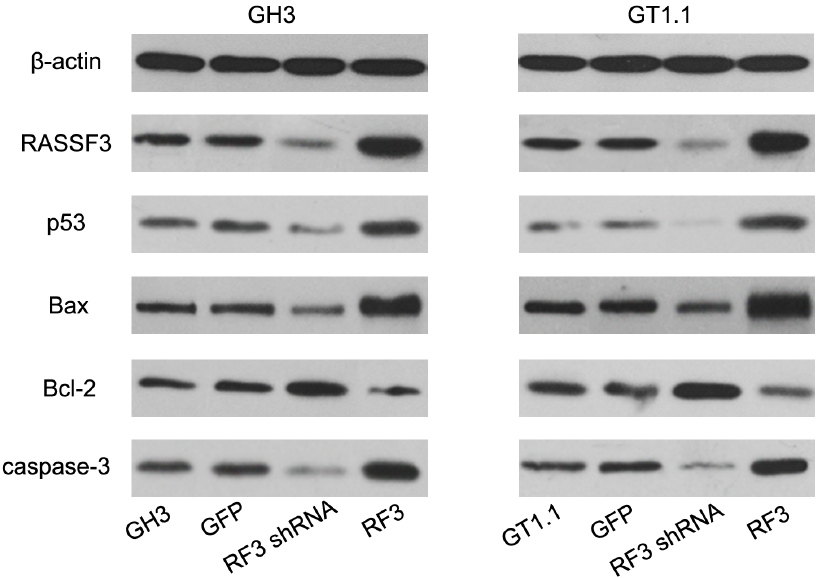
Figure 5. Western blotting analysis for RASSF3, p53, Bax, Bcl-2, and caspase-3. b -actin served as an endogenous control. Increased expression of p53, Bax, and caspase-3 and decreased expression of Bcl-2 were observed in GH3 and GT1.1 cells 72 h after Lenti-RASSF3 transfection as compared with the control groups (P , 0.05).